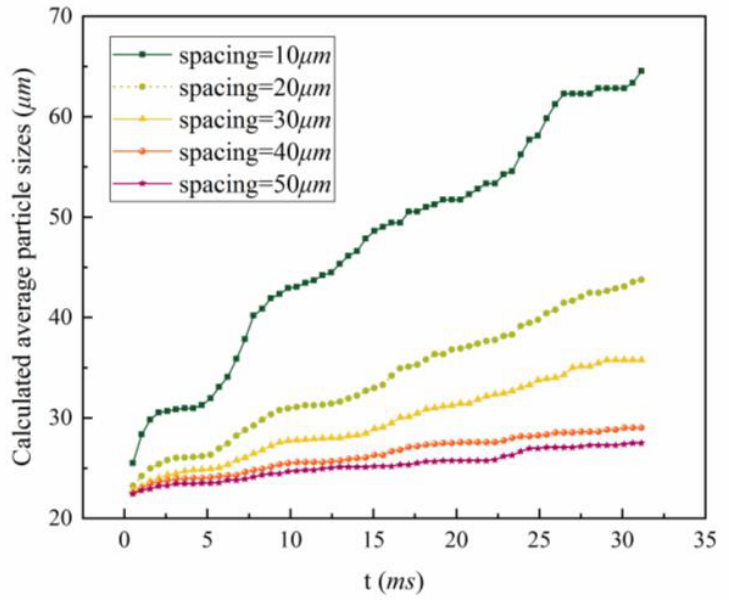
Figure 13. Variation of the average particle sizes under different spacing conditions.